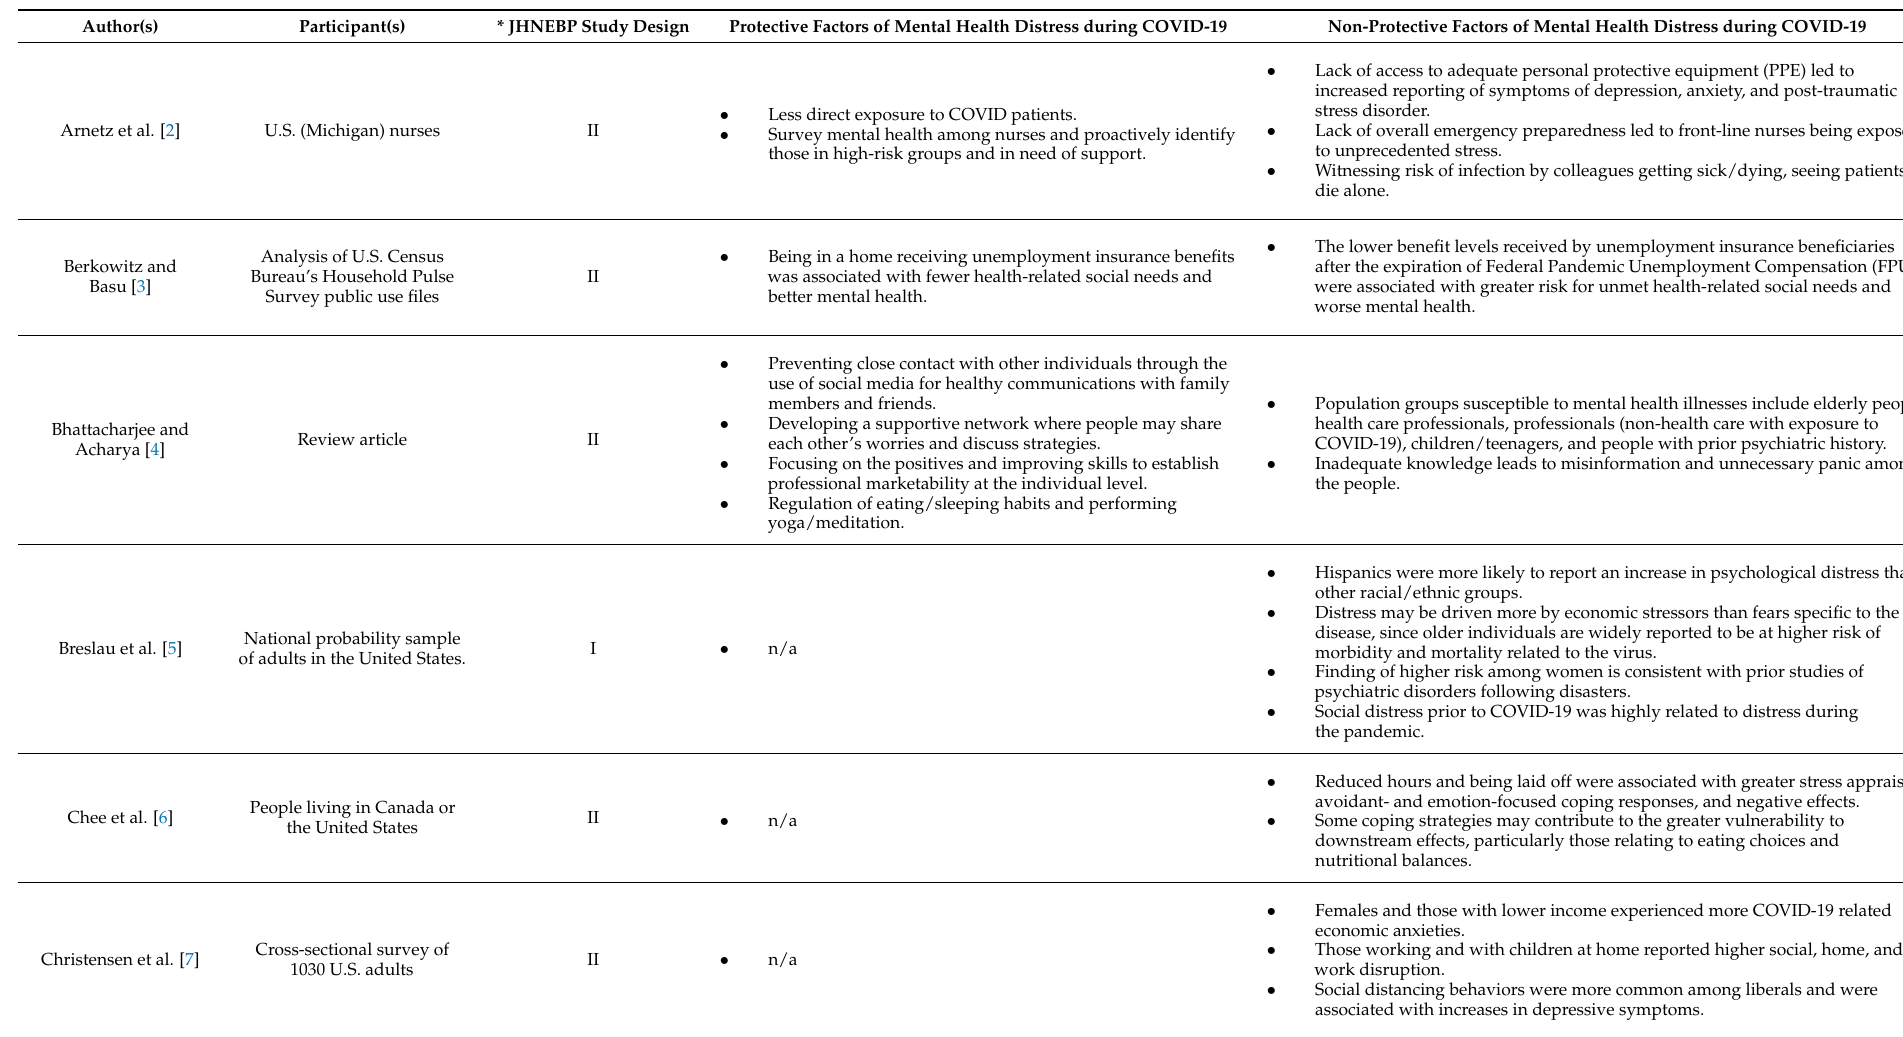
Table 2. Summary of findings (n =